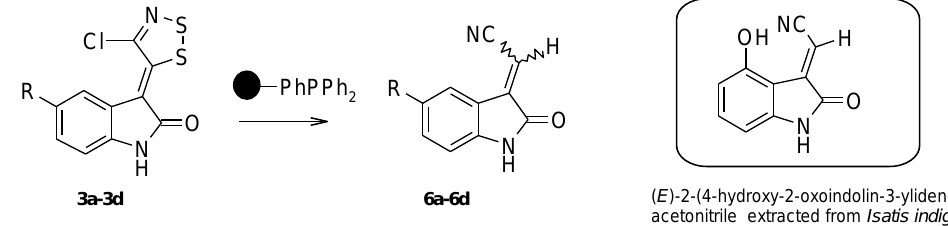
Scheme 5. Synthesis of 2-(2-oxoindolin-3-ylidene) derivatives ( 6a – 6d ) via the ring opening of alkenyldithiazole ( 3a – 3d ) with supported triphenylphosphine. Table 4. Yield of conversion of dithiazole ( 3a – 3d ) into 2-(2-oxindolil-3-ylidene)acetonitriles ( 6a – 6d ) with two equivalents of supported triphenylphosphine.